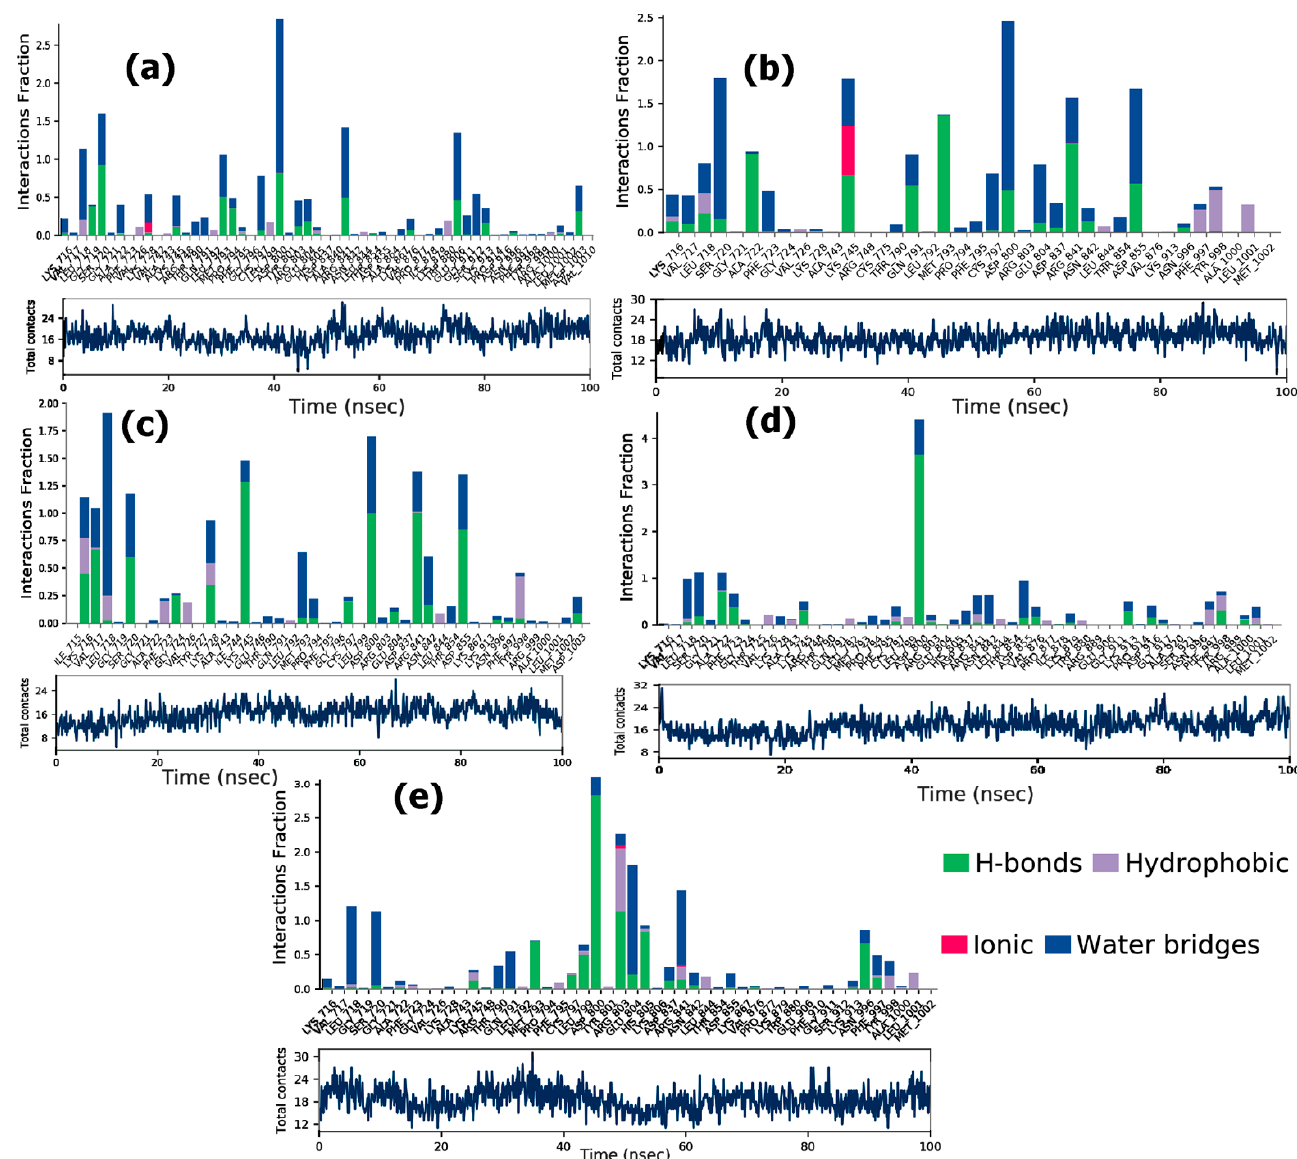
Figure 13. ( a ) Protein ligand contacts of EGFR-ligand complexes. ( a ) with Pep (top); total contacts with Pep (bottom); ( b ) with Mut1 (top); total contacts with Mut1 (bottom); ( c ) with Mut2 (top); total contacts with Mut2 (bottom); ( d ) with Mut3 (top); total contacts with Mut3 (bottom); ( e ) with Mut4 (top); total contacts with Mut4 (bottom).